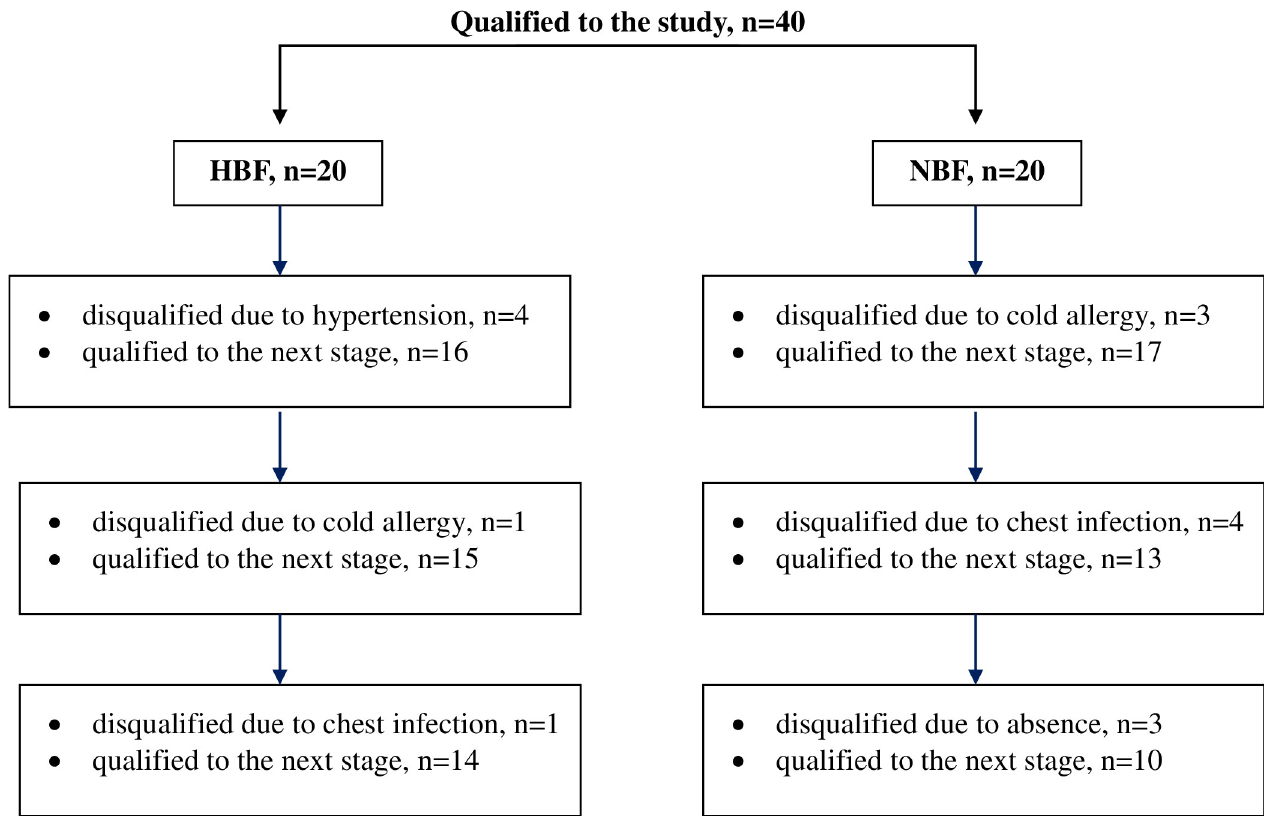
Fig 1. Factors disqualifying the study group during the project duration–patient flow diagram.